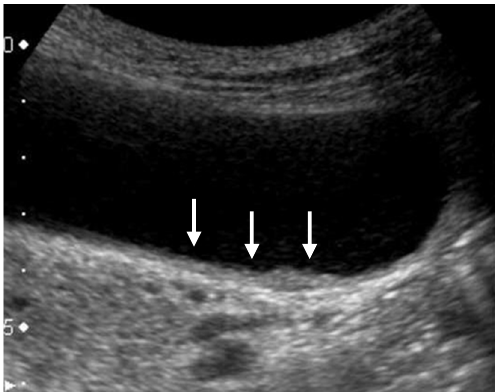
Figure 4. Focal presence of an inner hypoechoic layer (focal GWT). A high-frequency transducer with magnified image showed a slightly thickened inner hypoechoic layer less than 4-mm thick (arrow) in the fundus of GB (GBC case).